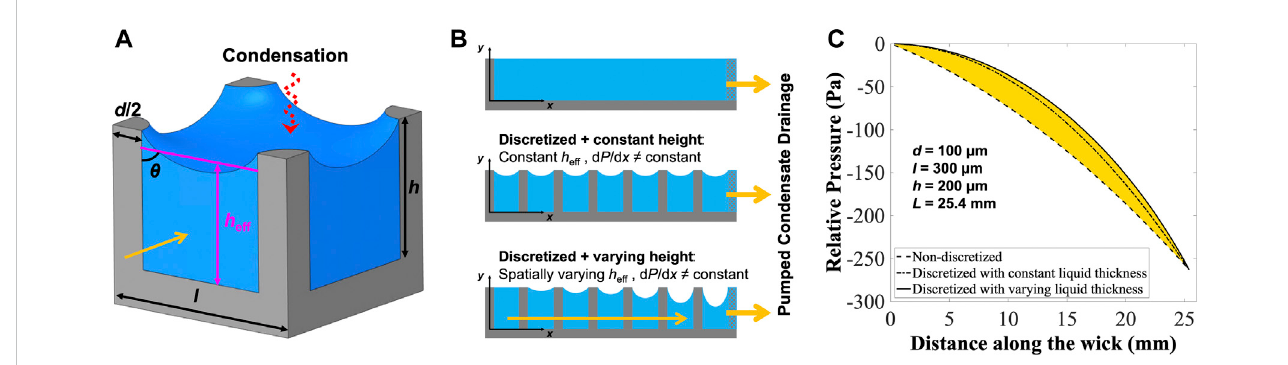
FIGURE 1 (A) The trimetric view of a discretized unit cell in a pillar array. (B) Schematic fi gure of the pillar arrays representing the non-discretized model and the discretized models with constant and varying liquid thickness (or pillar height). (C) Pro fi les of relative liquid (water) pressure along the pillar array wick calculated by the three different models with d = 100 μ m, l = 300 μ m, h = 200 µm and L = 25.4 mm. The predicted condensation heat fl ux is ≈ 105.5 W/cm 2 for the data in (C) with spatially varying effective liquid height, and the working fl uid is water at 30 °